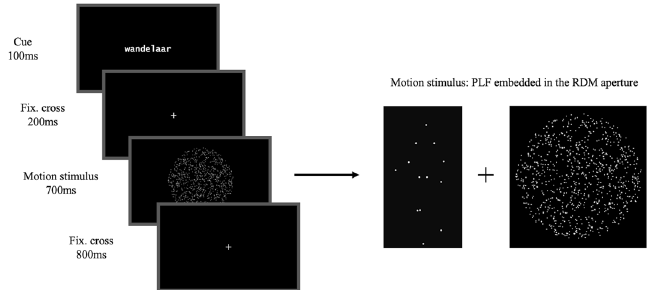
Figure 1. Trial design. A string cue is displayed at the beginning of every trial, before the target. The visual motion stimulus, comprised of a PLF figure (coherent or scrambled) embedded in an RDM aperture (upward or downward moving dots at a predetermined level of coherence), is presented in the middle of the screen. Participants have 1.5 s to respond—700 ms (motion stimulus) + 800 ms (fixation cross)—with the instruction to press the button, answering whether they saw coherent biological motion yes or no, as soon as